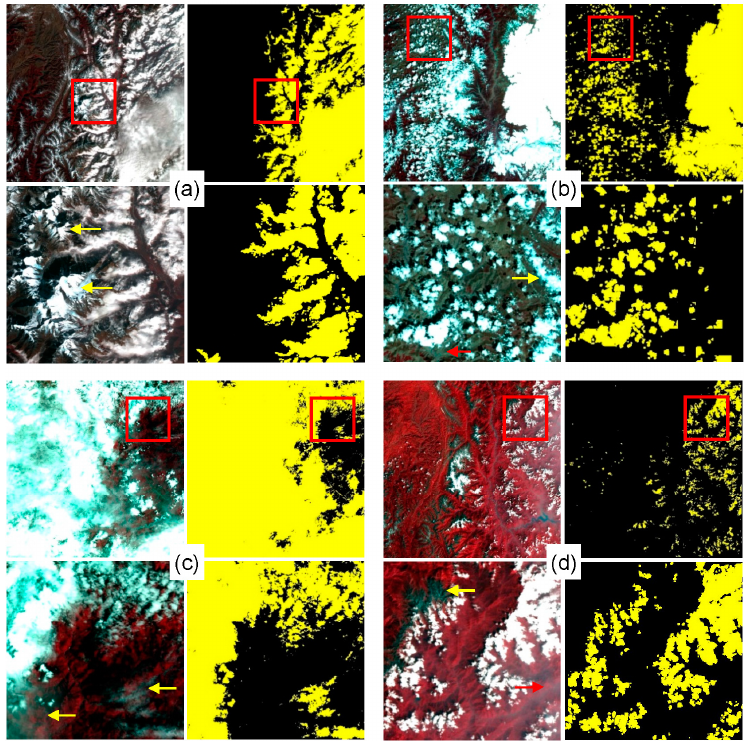
Figure 7. Cloud and snow separation results for four different dates. ( a ) Result of HJ1A-CCD1-20110114 scene; ( b ) Result of HJ1A-CCD1-20110414 scene; ( c ) Result of 12 June HJ1A-CCD2-20110612 scene; and ( d ) Result of HJ1B-CCD1-20110901 scene. For each date, ( Upper left ) and ( Upper right ) show false color composited HJ images and the corresponding cloud mask; and ( Lower left ) and ( Low right ) images are enlargements of ( Upper left ) and ( Upper right ) images, respectively with a size of 1000 pixels × 1000 pixels.